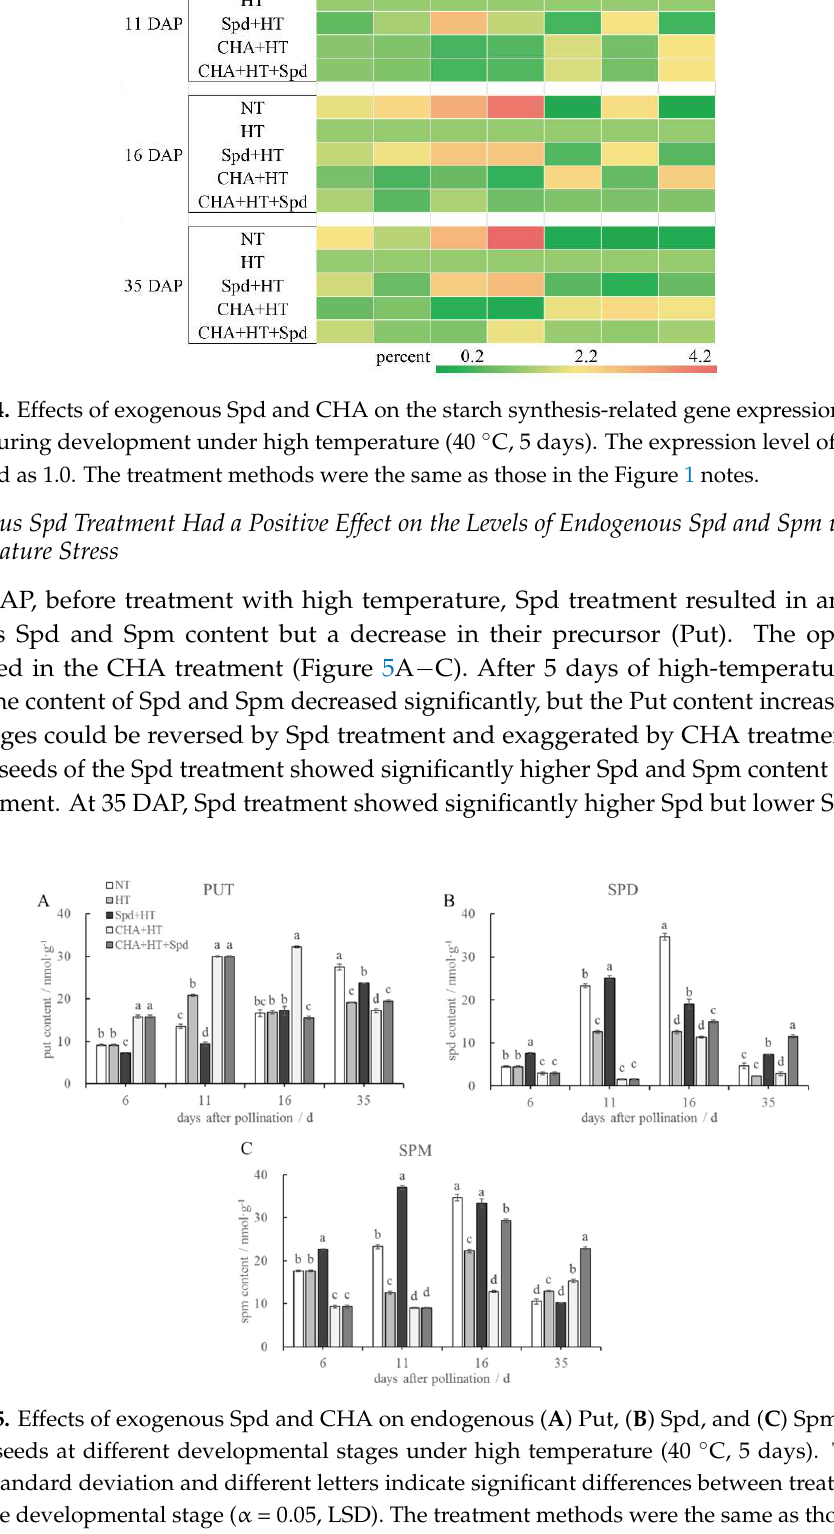
Figure 3. Effects of exogenous Spd and CHA on the contents of ( A ) total starch, ( B ) amylose, and ( C ) amylopectin in rice seeds at different developmental stages under high-temperature stress. The treatment methods were the same as those in the Figure 1 notes.